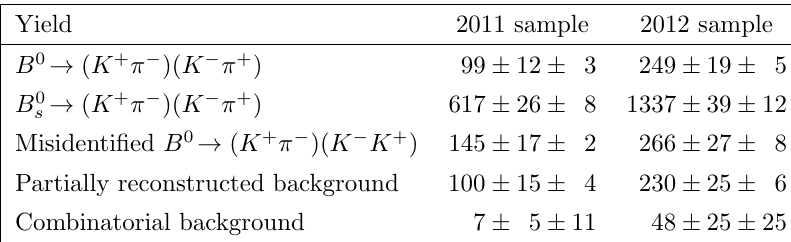
Figure 3 . Aggregated four-body invariant-mass (cid:12)t result of the 2011 and 2012 data. The solid red distribution corresponds to the B 0 ( K + (cid:25) (cid:0) )( K (cid:0) (cid:25) + ) decay, the solid cyan distribution to s ! B 0 ( K + (cid:25) (cid:0) )( K (cid:0) (cid:25) + ), the dotted dark blue line to (cid:3) 0 ( p(cid:25) (cid:0) )( K (cid:0) (cid:25) + ), the dotted yellow line to b ! ! B 0 ( K + (cid:25) (cid:0) )( K (cid:0) K + ) and the dotted cyan line represents the partially reconstructed background. ! The tiny combinatorial background contribution is not represented. The black points with error bars correspond to data to which the B 0 (cid:26) 0 K (cid:3) 0 contribution has been subtracted with negatively ! weighted simulation, and the overall (cid:12)t is represented by the thick blue line.